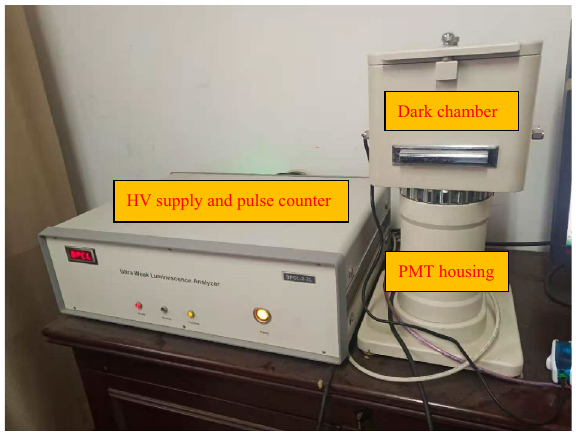
Figure 2. Ultra weak luminescence measurement instrument used in the